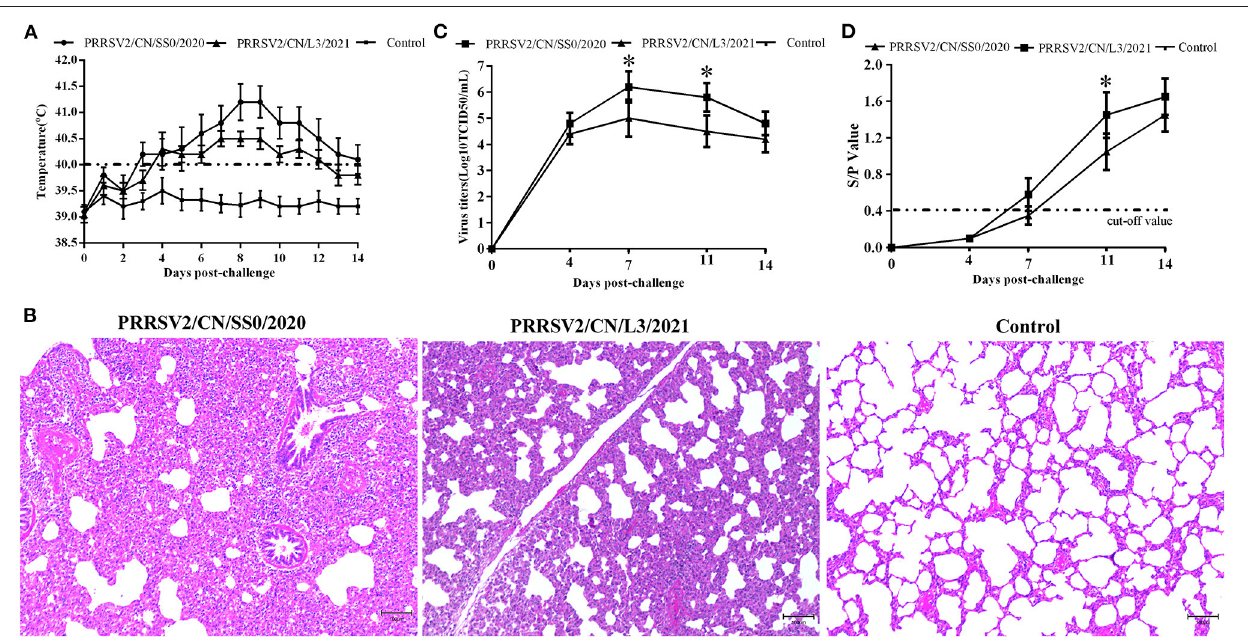
FIGURE 5 | The rectal temperature, microscopic lung lesions, viremia, and antibody levels of pigs during the challenge experiment. (A) Rectal temperatures of pigs inoculated with PRRSV2/CN/SS0/2020, PRRSV2/CN/L3/2021, and DMEM. The clinical fever cut-off value was set at 40 ◦ C. (B) Microscopic lung lesions of the inoculated pigs. (C) Dynamics of viral loads of the inoculated pigs during the experiment. (D) PRRSV-specific antibodies response in serum of challenged pigs. The cut-off value for seroconversion was set at a sample-to-positive (s/p) ratio of 0.4. Data are expressed as mean ± standard deviation (S.D). Asterisk indicates significant differences between the PRRSV2/CN/SS0/2020- and PRRSV2/CN/L3/2021-infected groups (* p <